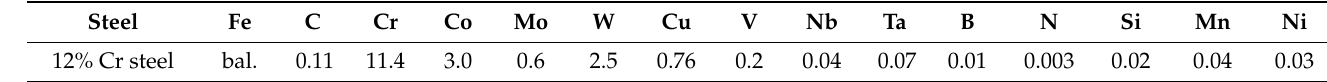
Table 1. Chemical composition of the Co-modified 12% Cr steel